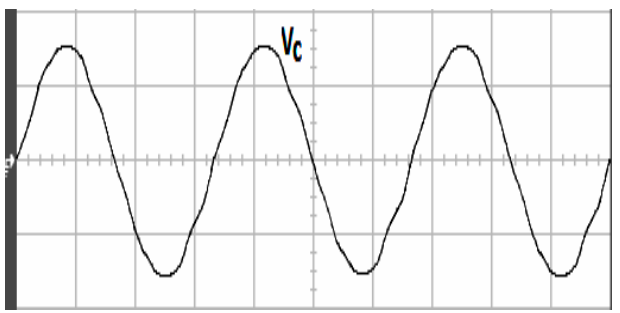
Figure 10. Experimental output-voltage under LC variation with the classical TSMC (100 V/div; 5